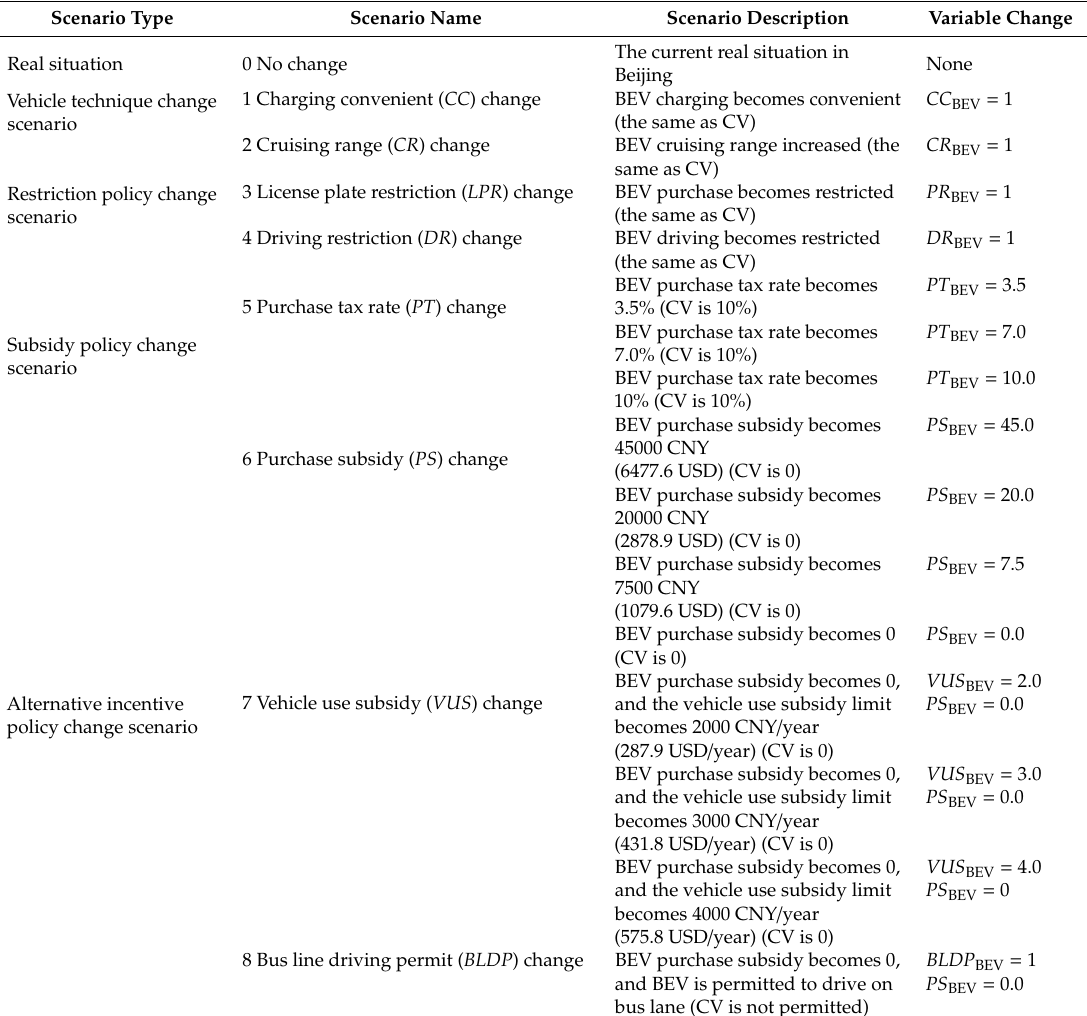
Table 3. Survey scenario